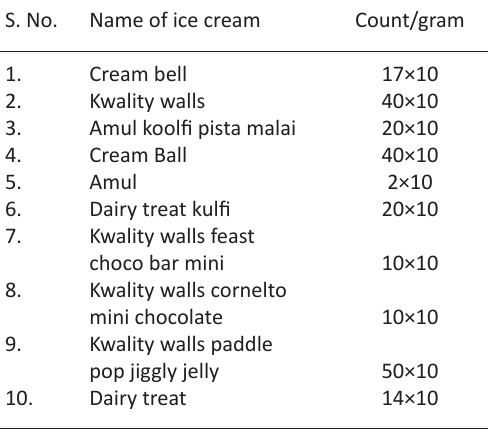
Table 1. Colonies count of each collected sample S. No.